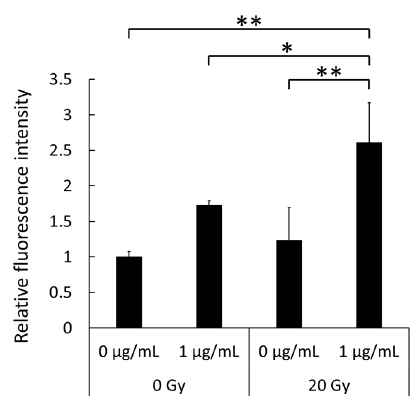
6 of 9 Figure 3. Intracellular levels of peroxynitrite in RAW264 macrophages treated with 0 or 1 µg/mL lipopolysaccharide (LPS) for 24 h followed by irradiation with 0 Gy or 20 Gy X-rays. Statistical significance was assessed using Tukey’s test. Data are shown as mean ± standard deviation; n = 12. * p < 0.05, ** p < 0.01. 3.4. Elevated Accumulation of Hematoporphyrin in Cells